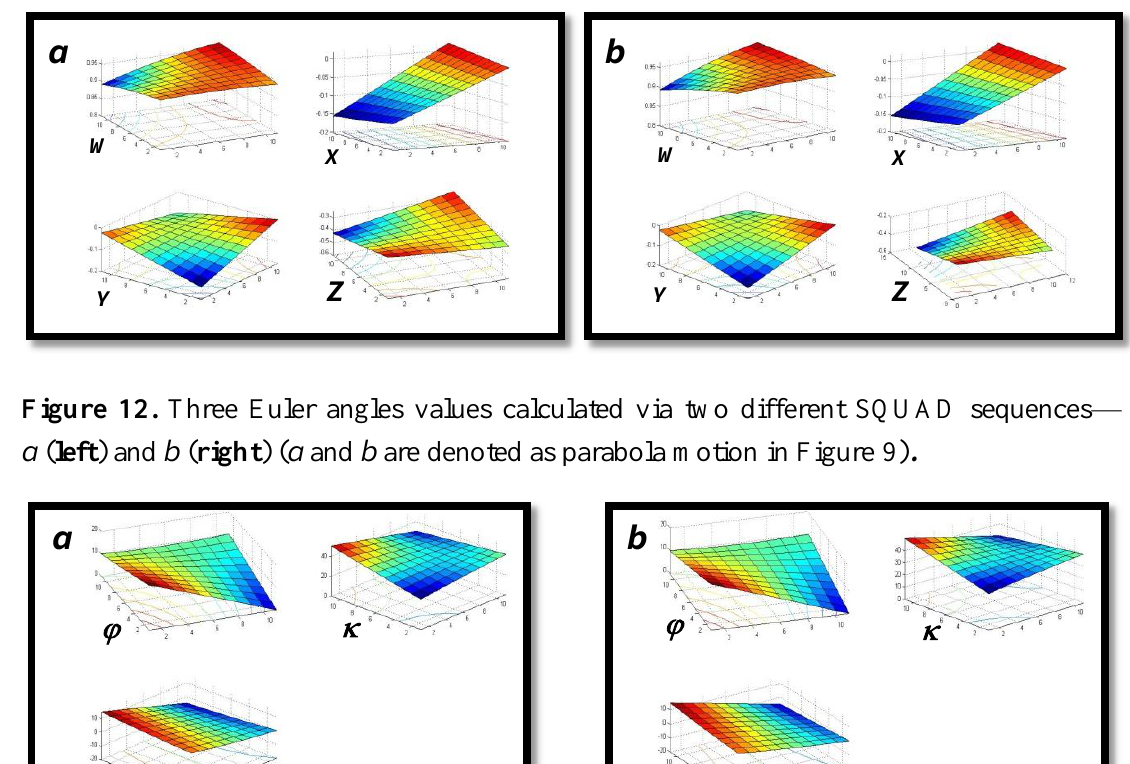
Figure 11. Four unit-quaternion coefficient values calculated via two different SQUAD sequences— a ( left ) and b ( right ) ( a and b are denoted as parabola motion in Figure 9) .